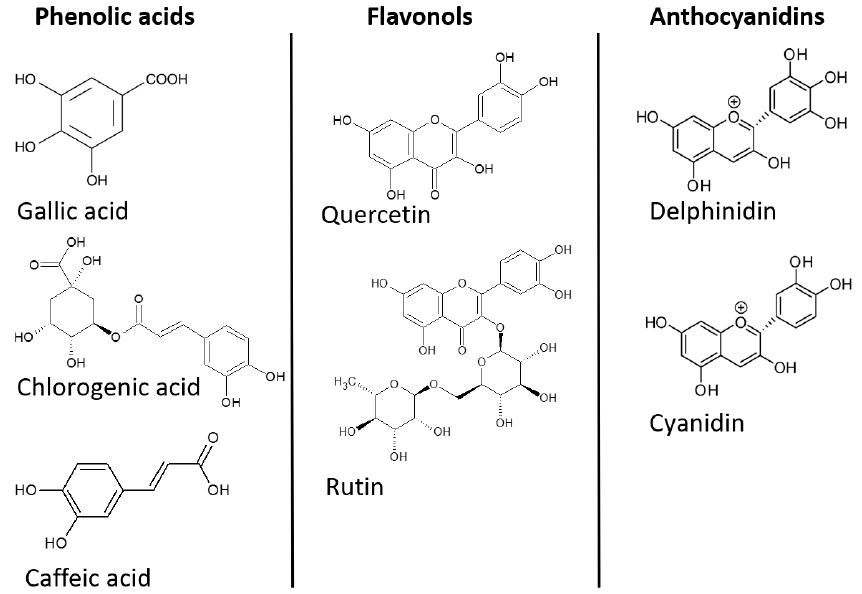
Figure 2. Three types of phenylpropanoid classes in plants. Plants contain tens of thousands of different phenylpropanoids. Examples are shown of some common phenolic acids, flavonols and anthocyandins found in many fruits and vegetables.